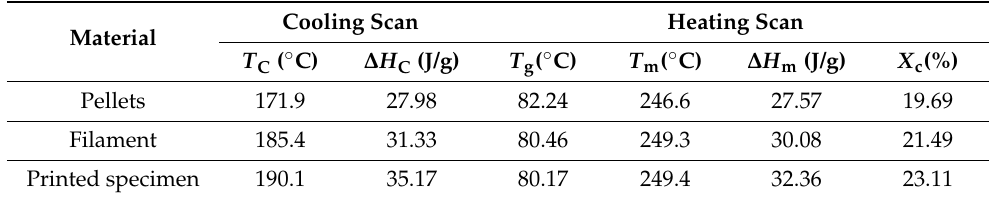
) of PET pellets, filaments, V